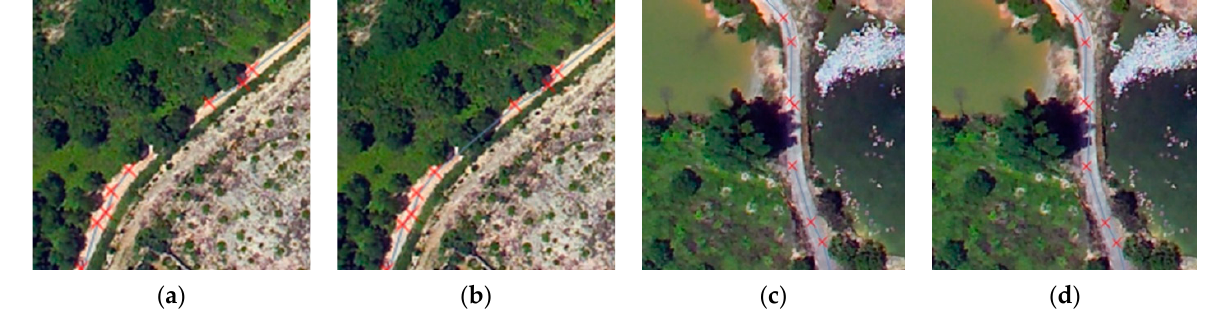
Figure 11. The road connection results: ( a , c ) depict the roads to be connected; ( b , d ) are the respective road connection results. road connection results.